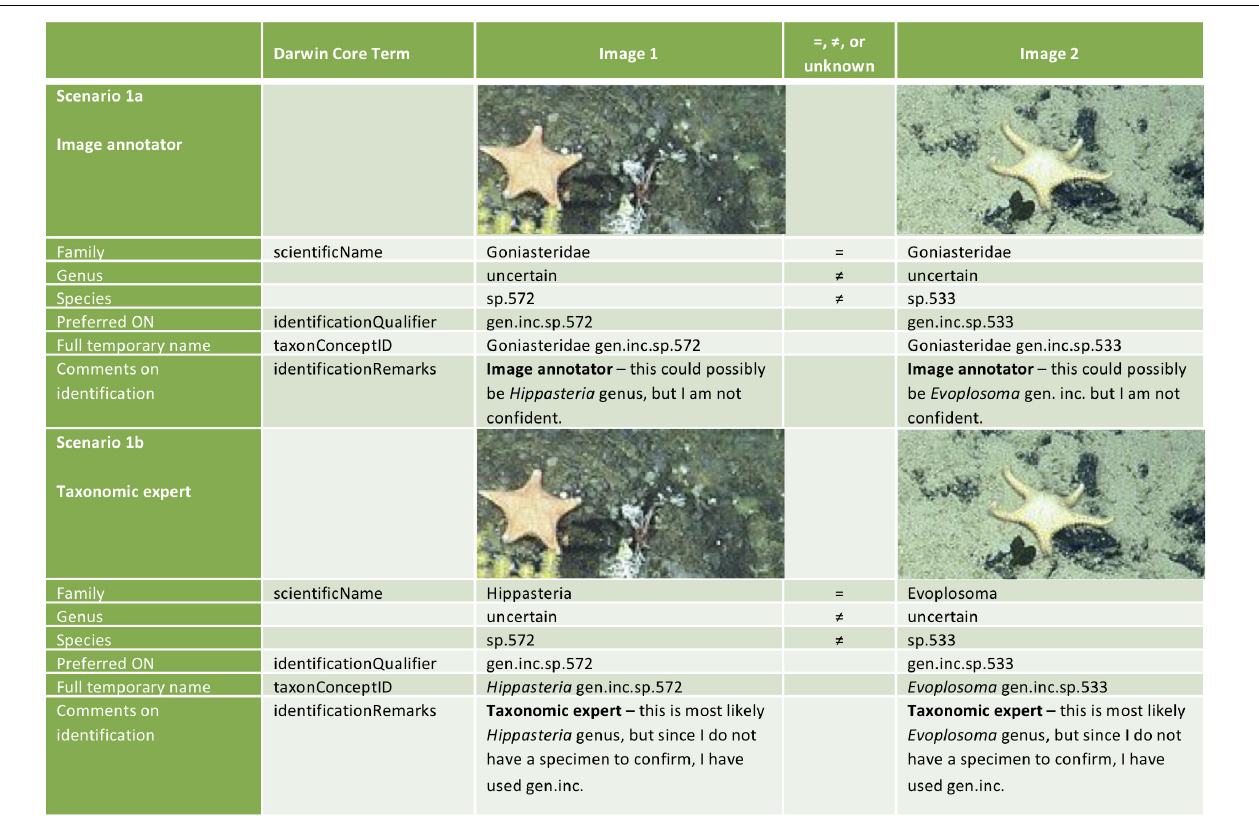
FIGURE 6 | Examples of how to format the identification for input to online databases in Darwin Core format for an image annotator vs. taxonomic expert identification. Example scenarios are for two taxa indicating where identification at the taxonomic levels of family, genus, and species are the same ‘=,’ different ‘ (cid:54)= ,’ or if this information is unknown. Image 1 and 2 are reproduced from Buglass et al. (2019).